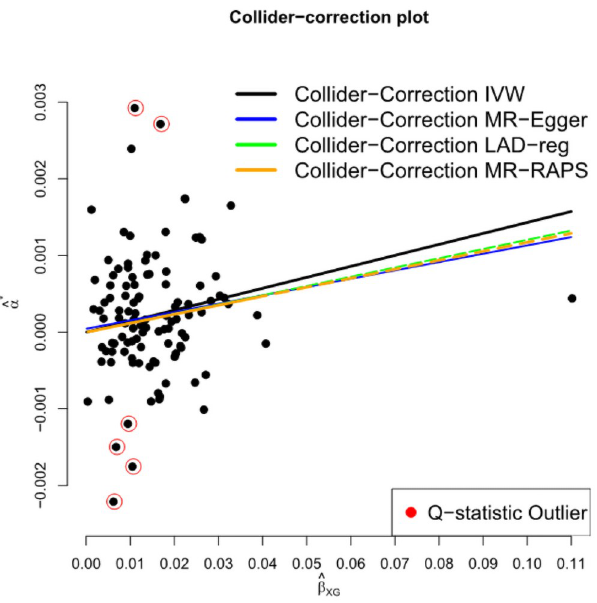
Fig 16. Collider biased SNP outcome associations, ^ a � were genome-wide significant using 23andMe data